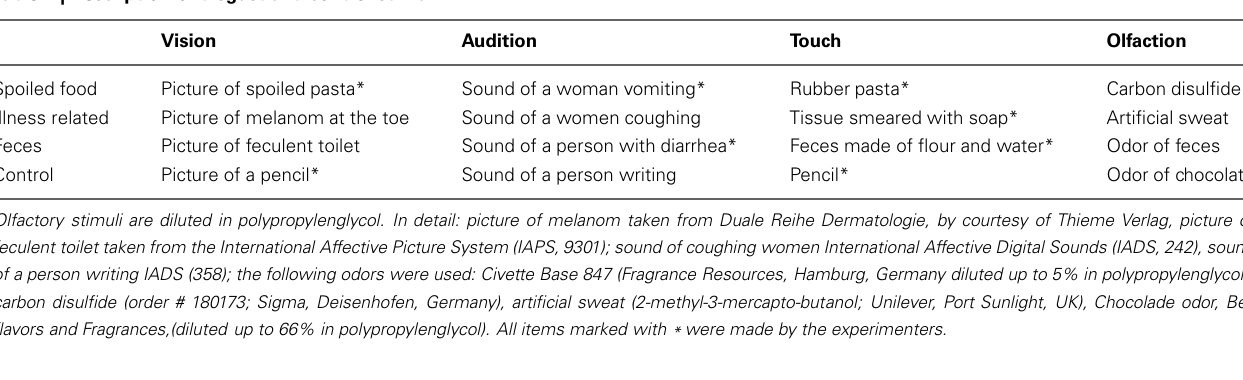
Table 1 | Description of disgust and control